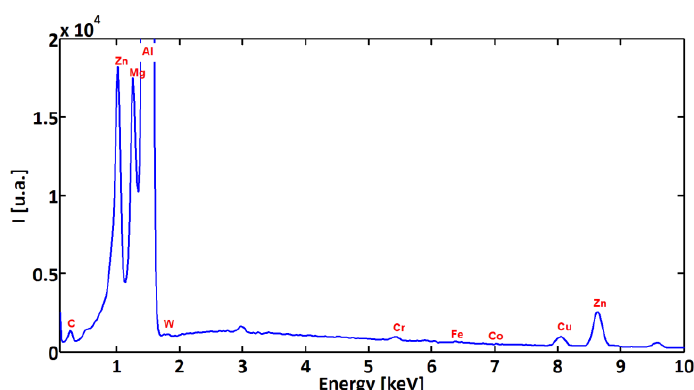
Figure 10. EDS spectra acquired on a machined